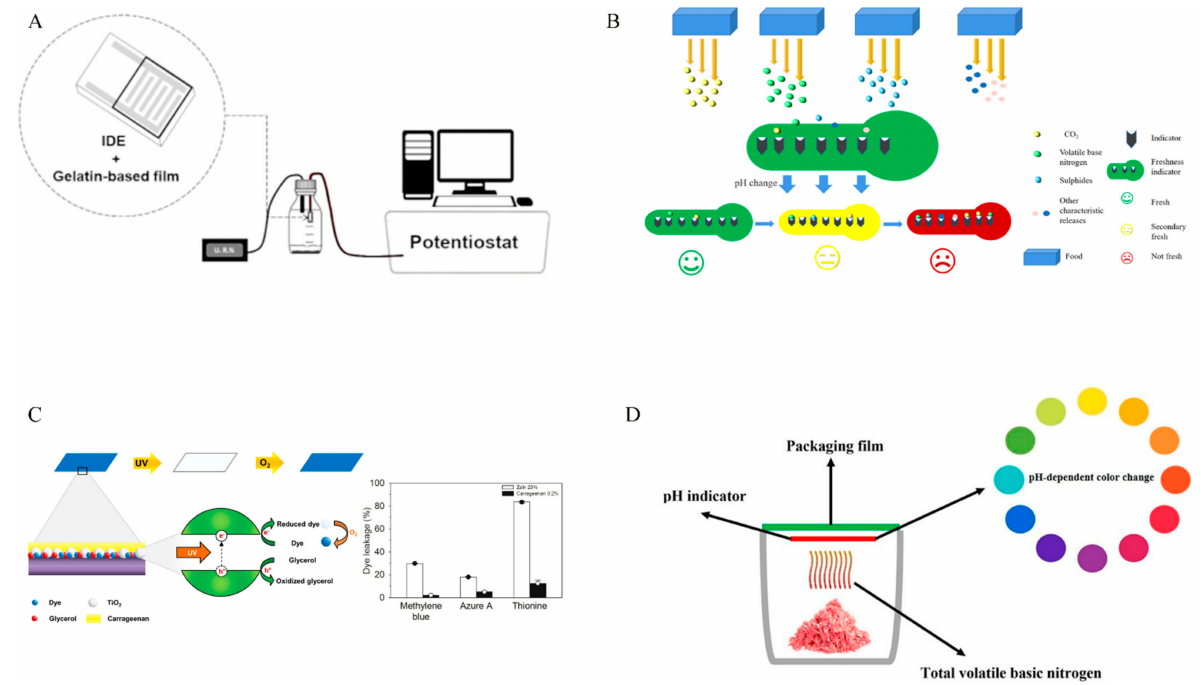
Figure 2. The working principle of indicators in food intelligent packaging. ( A ) TTI; ( B ) FI; ( C ) LI; ( D ) PHI. Reproduced from Refs. [2,25–27] with